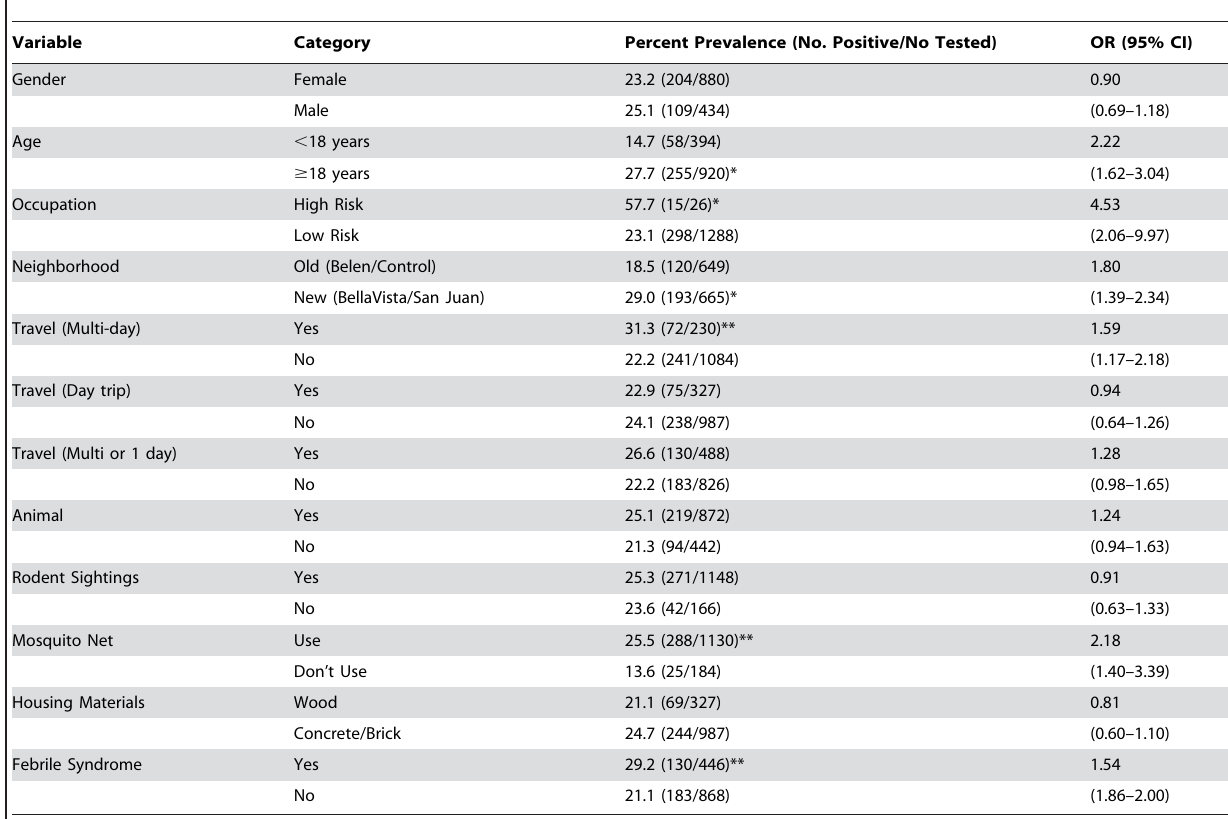
Table 5. VEEV antibody prevalence by potential risk factors for infection and odds ratio in univariate logistic regression.